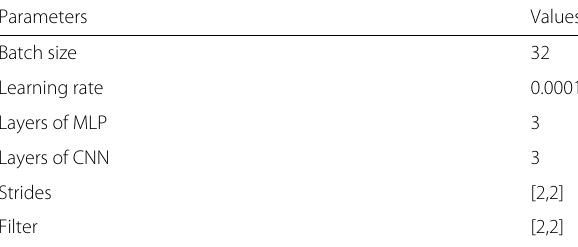
Table 1 Important parameters of